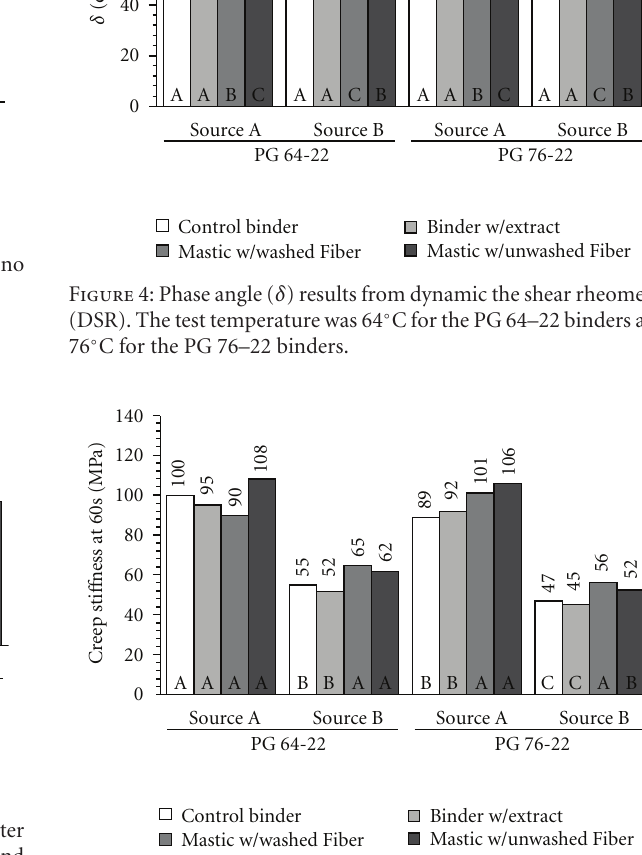
Figure 5: Creep sti ff ness ( S ) results from the bending beam rheom- eter (BBR). The test temperature was − 12 ◦ C for all